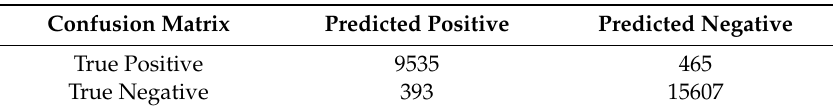
Table 7. Confusion Matrix.